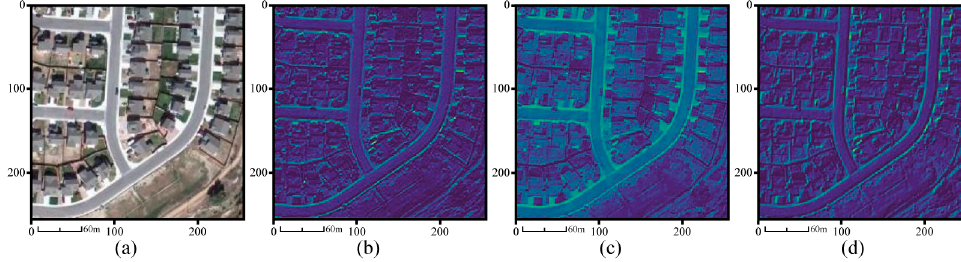
Figure 5. The original image ( a ) and a part of feature maps ( b – d ) of first layer of designed model.